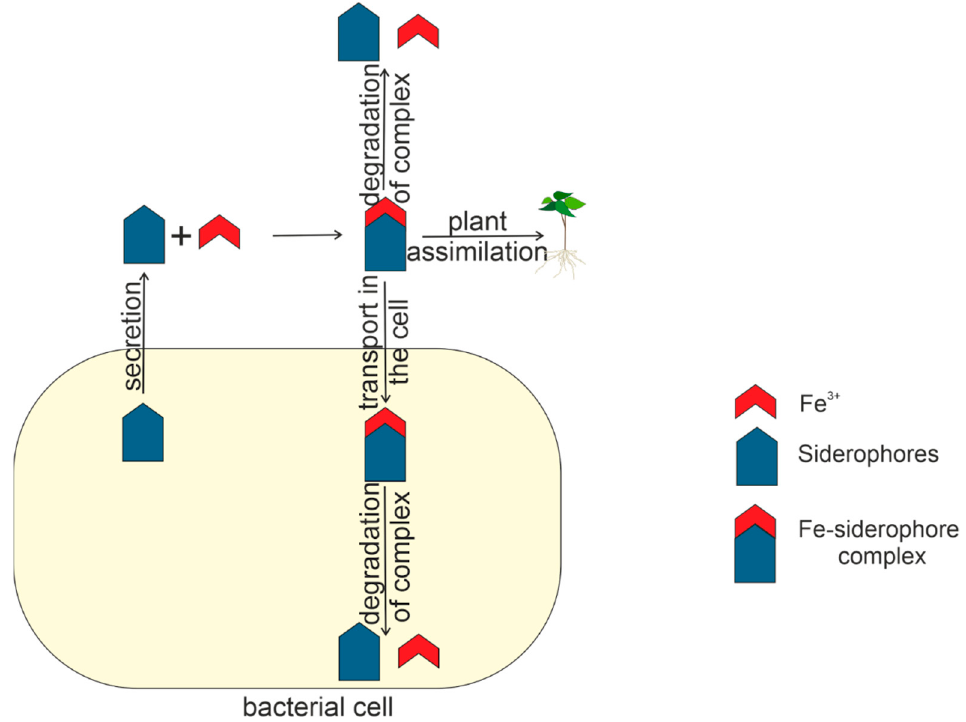
Figure 7. The life cycle of siderophore in and outside the bacterial